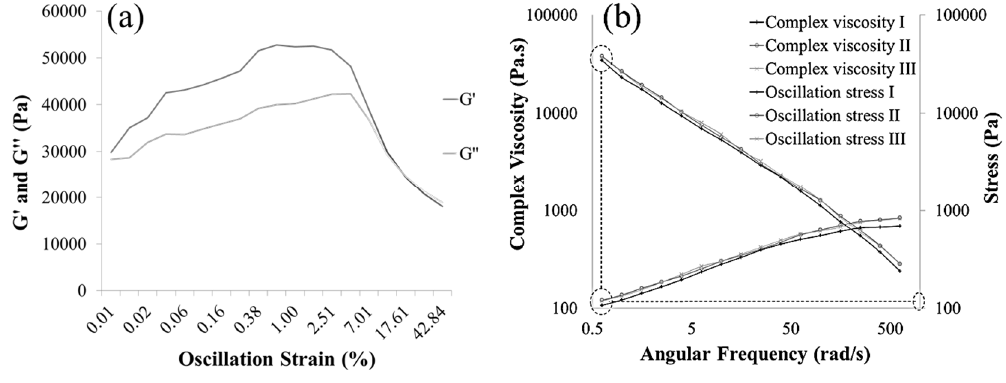
Figure 1. The graphical representations of ( a ) the acquisition of the linear viscoelastic region and ( b ) the extrusion stress of the materials examined. The near-zero complex viscosity was correlated to the stress value at that point to yield extrusion stress as indicated in the graph ( b ) with dashed